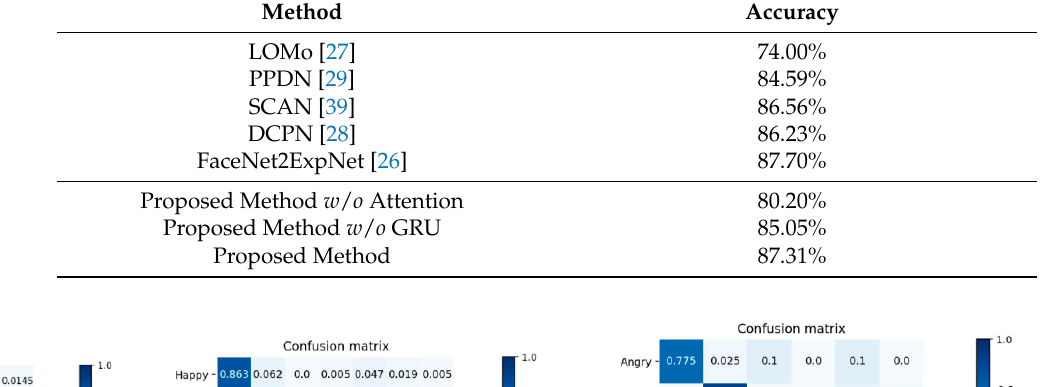
Table 4. Comparison of methods on Oulu-CASIA dataset.